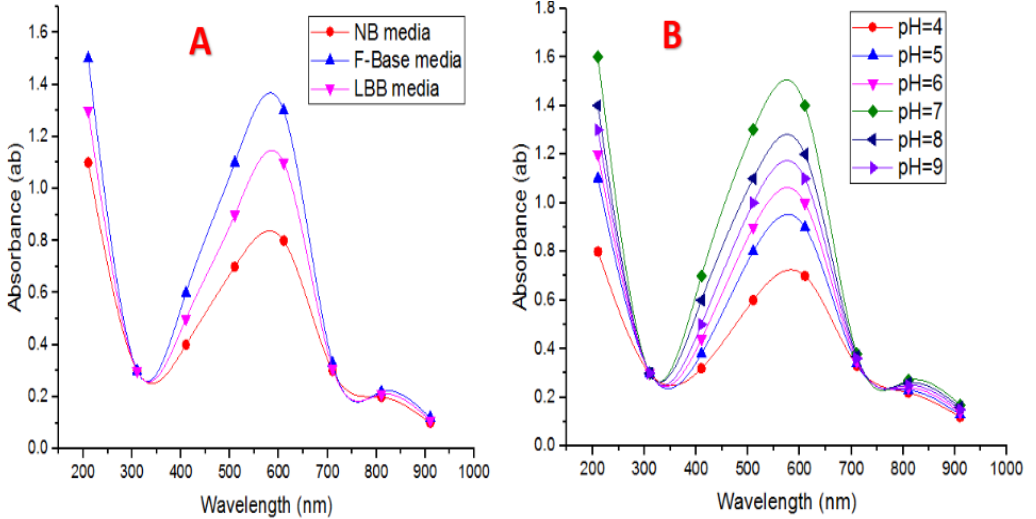
Figure 2. ( A ) UV–Vis spectra of medium type. ( B ) UV–Vis spectra of different pH values utilized throughout CuNPs biotransformation by P. fluorescens MAL2.